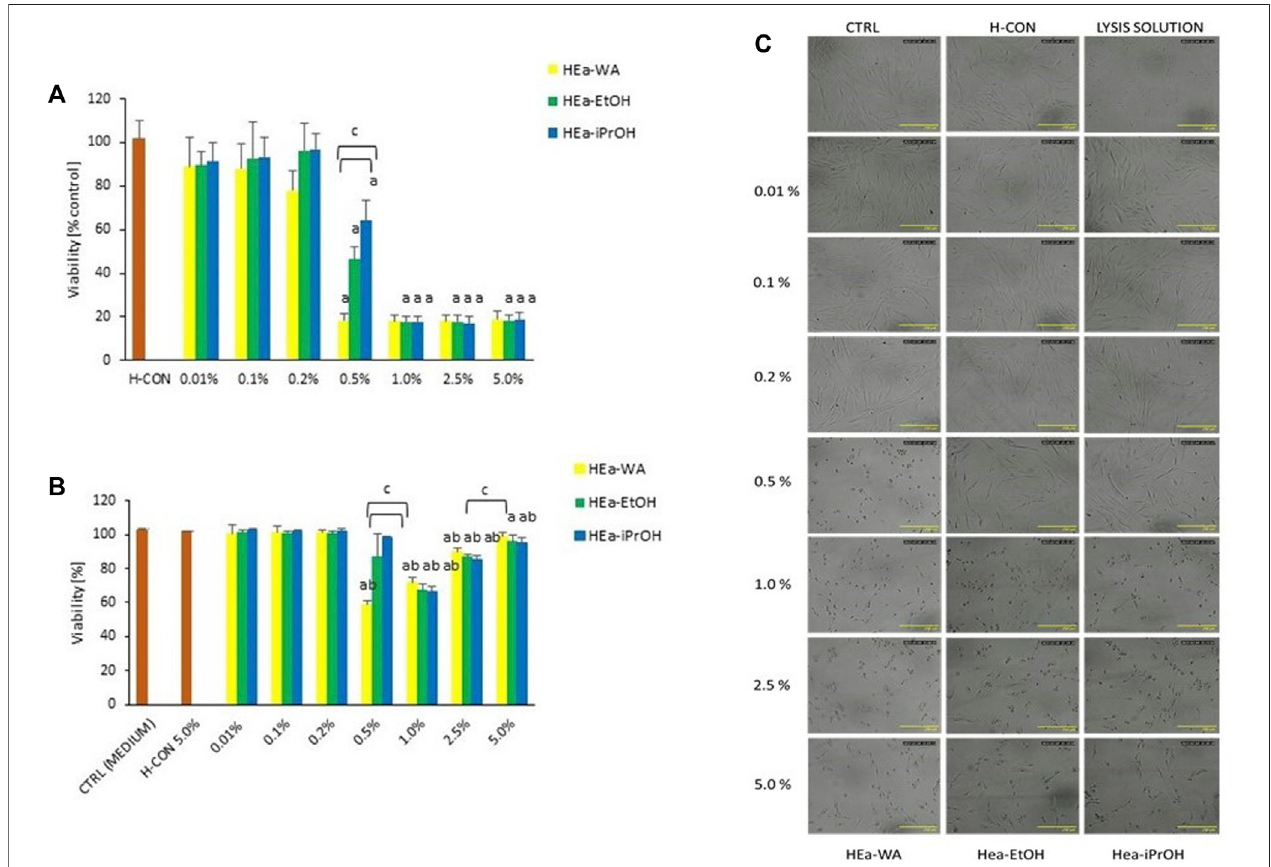
FIGURE 5 | Wound healing assay activity of the hydrogels at 0.2% (100 μ g/ml of E. angustifolium extracts) and medium as a negative control. The mean and SD of the cell migration from three independent experiments is shown: b = p < 0.05 vs. HEa-WA.